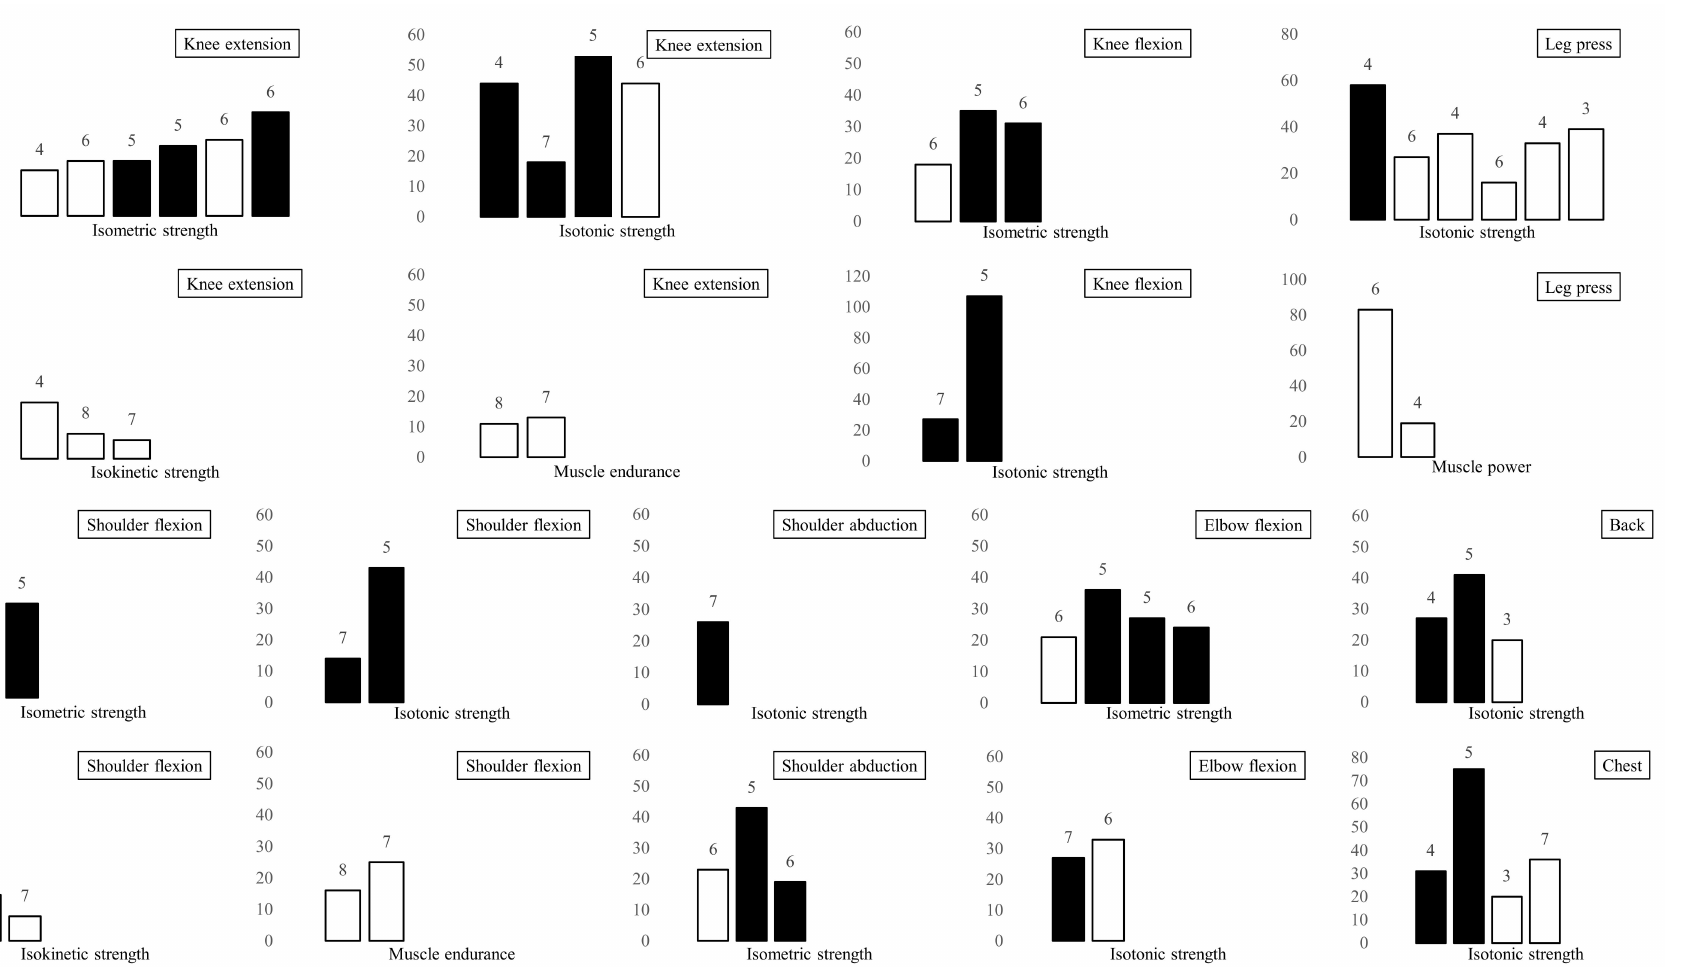
Figure 2. Harvest plots of the effect of isolated RT on peripheral muscle function in outpatients with COPD. Changes for the various outcome measures are expressed as percentage of baseline. For studies that adopted more than one modality of RT (e.g., conventional RT or RT with elastic bands), the highest increase was reported. Numbers above the bars refer to the quality score of the studies (from 0 to 10). The length of the training program is indicated by black bars (36 sessions) or white bars (24 sessions). Combined exercises for chest muscles (i.e., chest press and butterfly) and back muscles (i.e., lat pull) are grouped in the “chest” and “back” graphs,